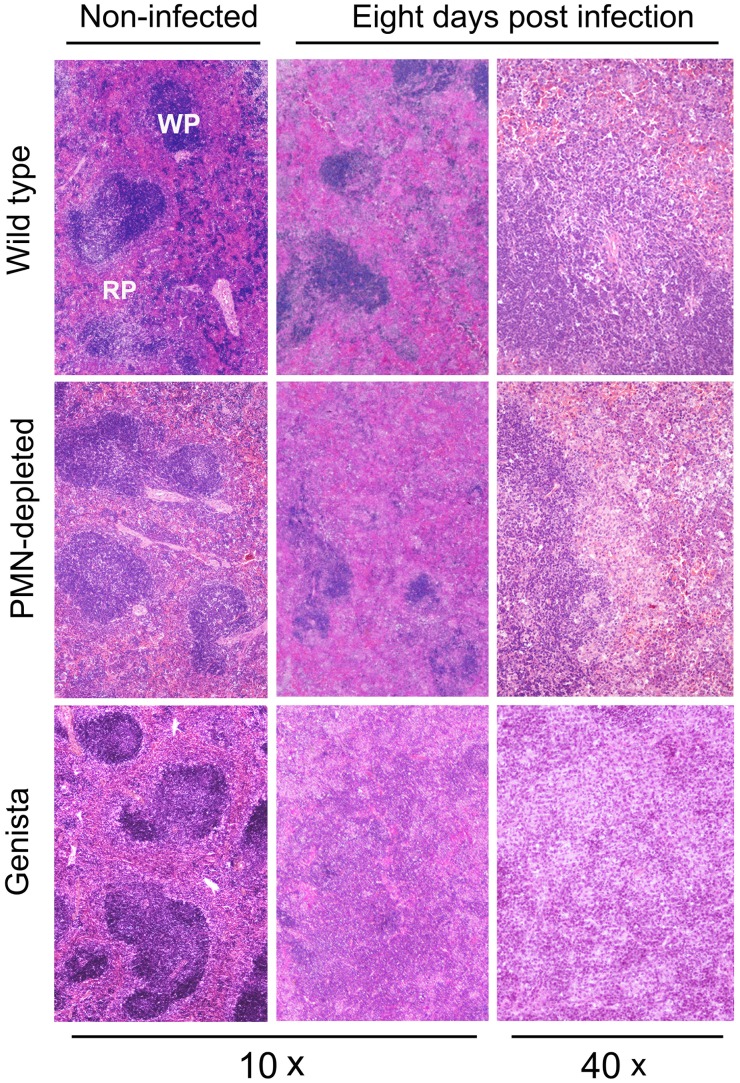
Lymphoid depletion, macrophage infiltration and granuloma formation becomes more prominent in spleens of PMN-depleted and Genista than in WT Brucella infected mice.Spleens from infected (106 CFUs) and PBS-treated mice were fixed and stained with hematoxylin and eosin stain. The absence of PMNs in Genista or PMN-depleted non-infected mice did not affect the normal distribution of white pulp (WP) and red pulp (RP) or the overall histological structure of the spleen.